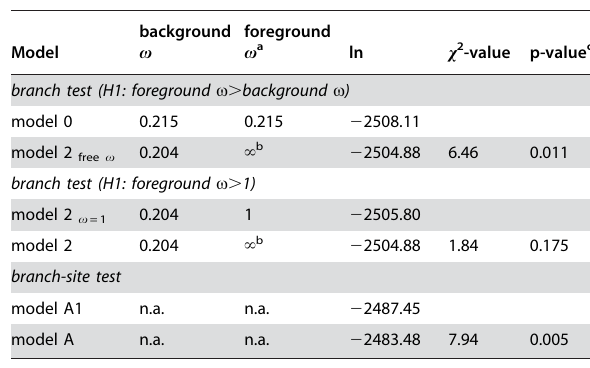
Table 5. Likelihood Ratio Test for positive selection on LRIM1